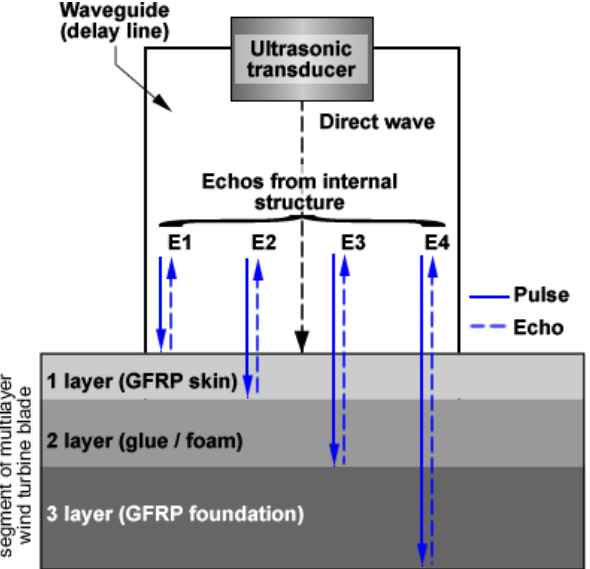
Figure 11. Principle of the pulse-echo technique used for the investigation of WT blades [100,103]. GFRP: glass fiber reinforced plastic. Reprinted/Reproduced with permission from [100]. Copyright 2008, Kaunas University of